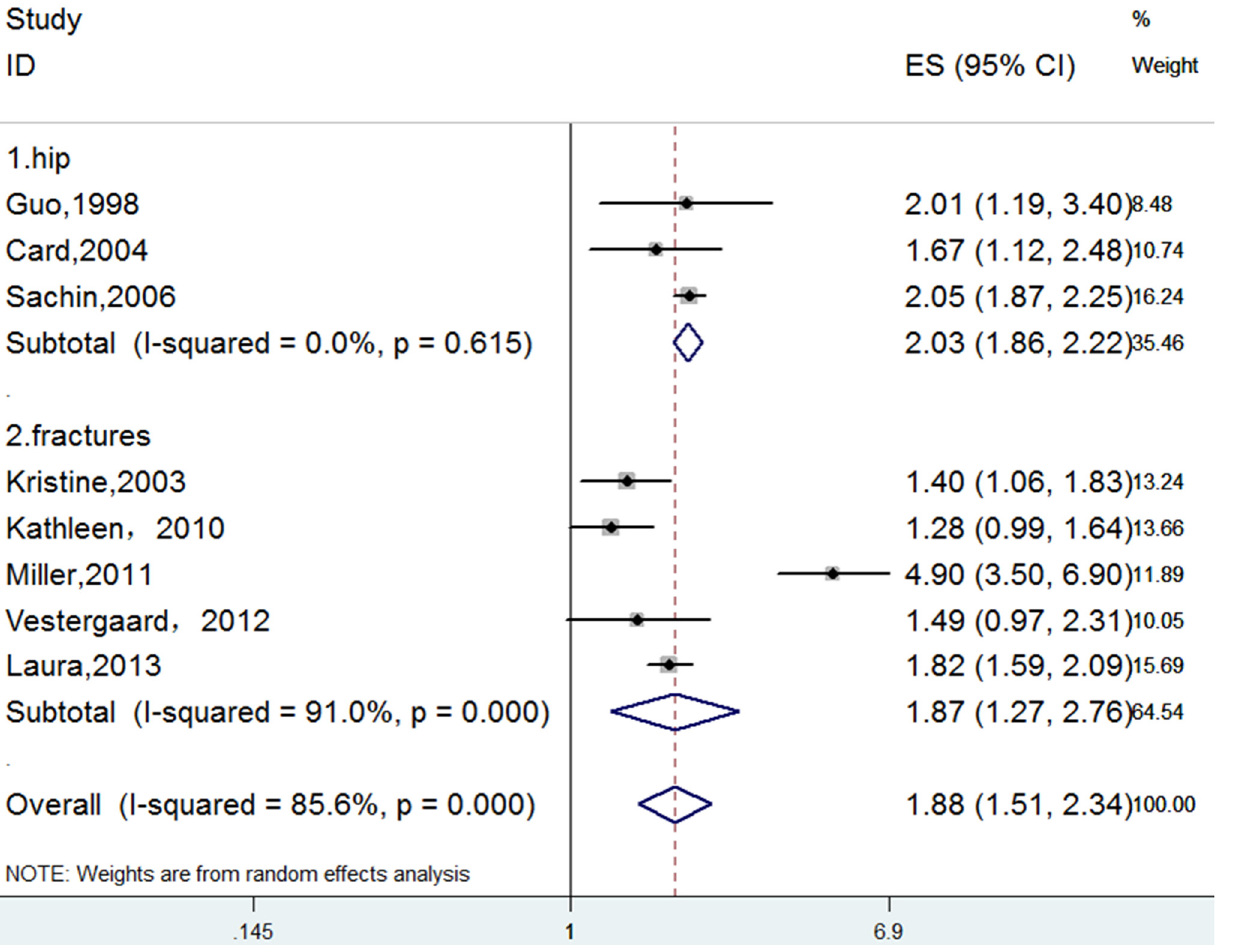
Fig 4. Forest Plot for a Subgroup Meta-analysis by Anatomical Fracture Site.